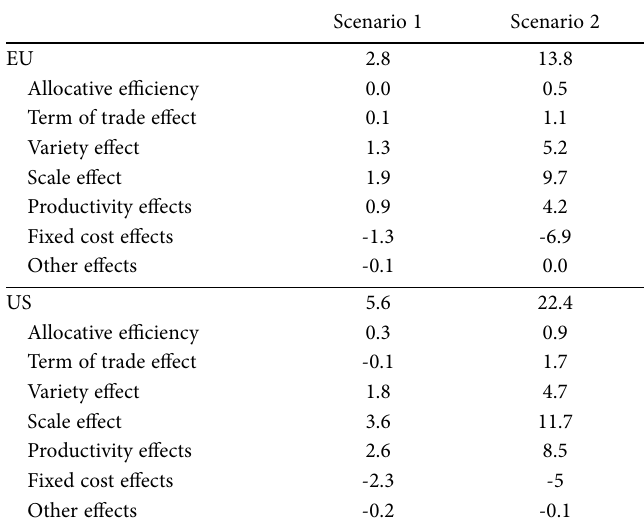
Table 6. Welfare decomposition